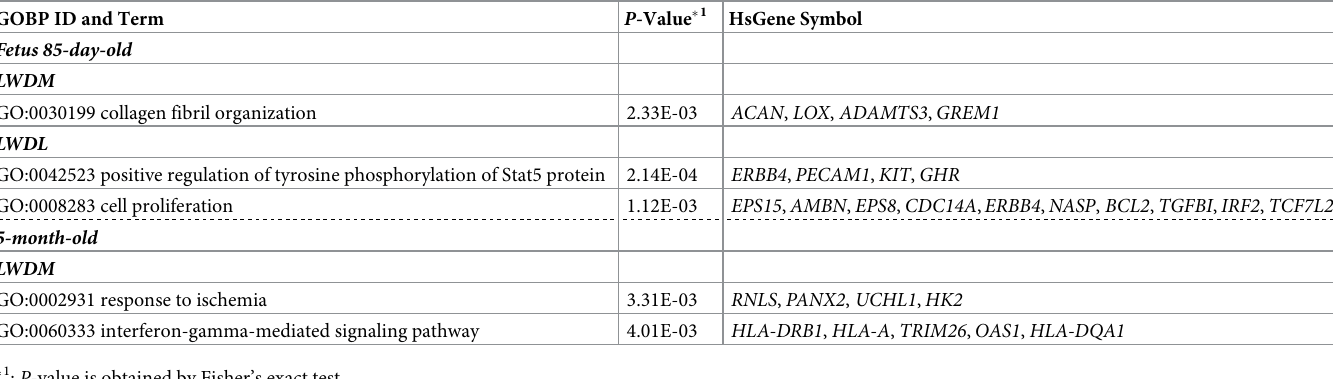
Table 6. Annotation profile of the genes with > 2.0-fold predominant expression in the skeletal muscle (muscle) tissue of LWDM and LWDL pigs. GOBP ID and